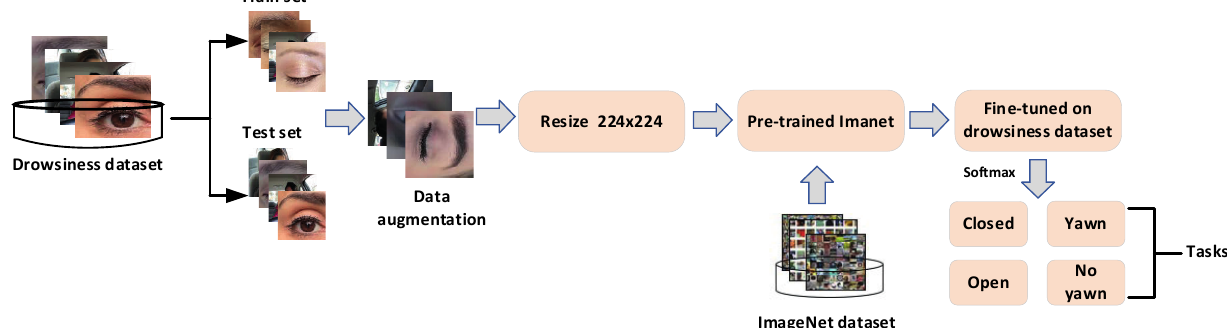
Fig. 3. Flow chart of the proposed method for transfer learning-based determination of driver dynamics while